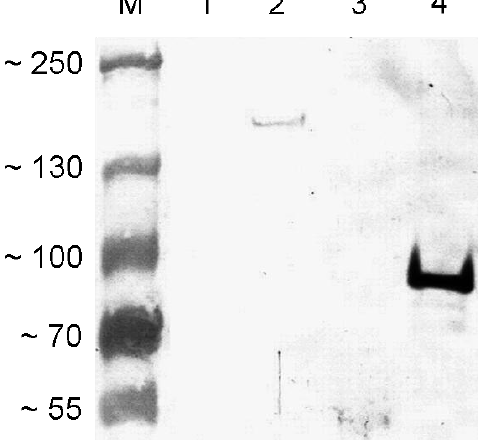
Figure 3. Western blot on E. faecalis protein extracts and purified Agg